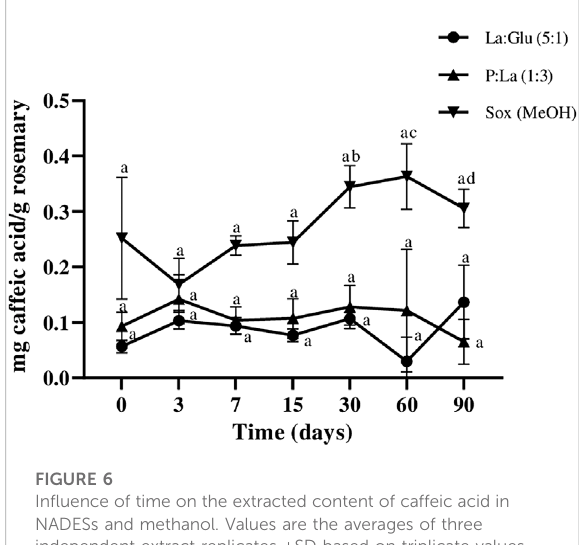
FIGURE 4 In fl uence of time on the extracted content of carnosol (C) in NADESs and methanol. Values are the average of three independent extracts replicates ±SD based on triplicate values. Statistically signi fi cant differences between the time points in each system are represented by letters. Different letters indicate signi fi cant differences within each system.